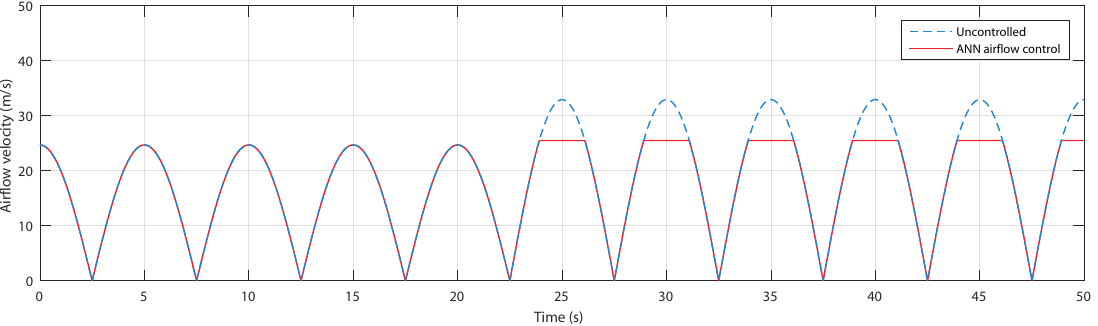
Figure 15. Airflow speed for uncontrolled case and ANN-based airflow control.